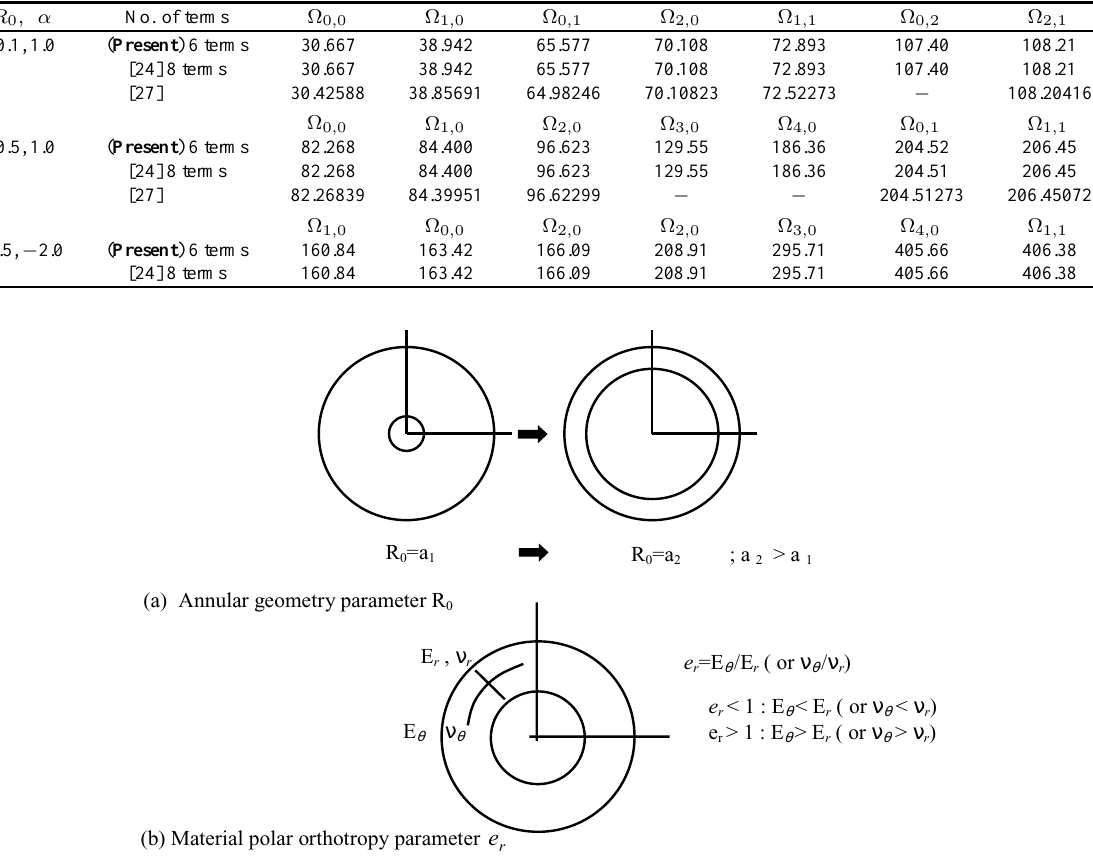
Fig. 3. Meaning of annular geometry parameter R 0 and material polar orthotropy e r